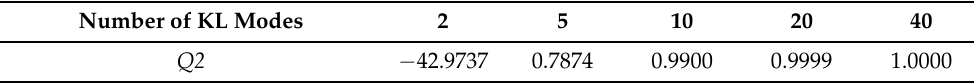
Table 3. Predictivity factor Q2 as a function of the number of KL modes.